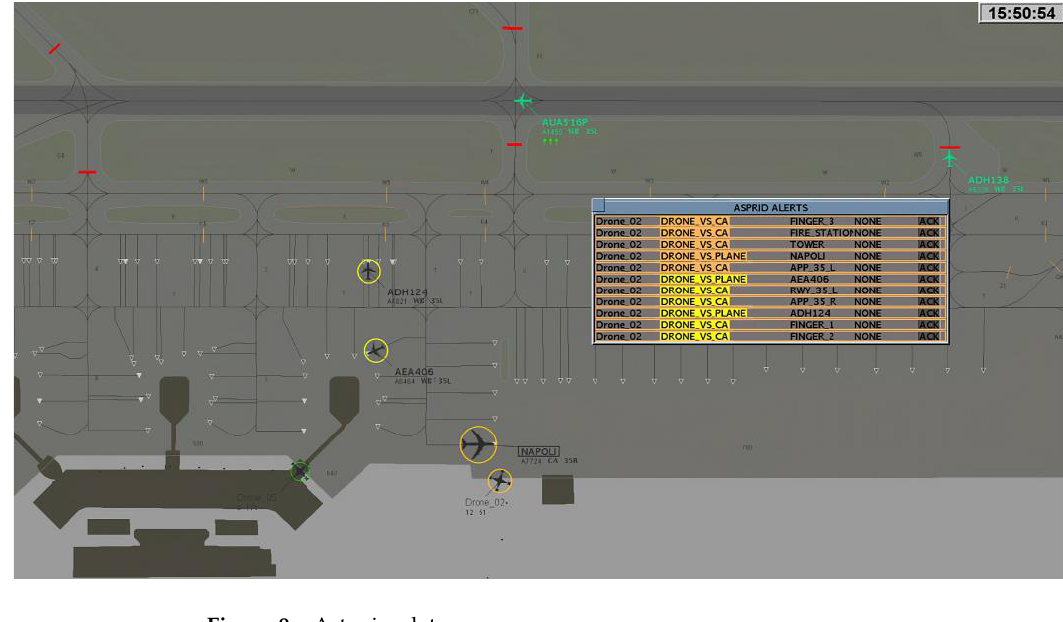
Figure 9. eArts simulator.